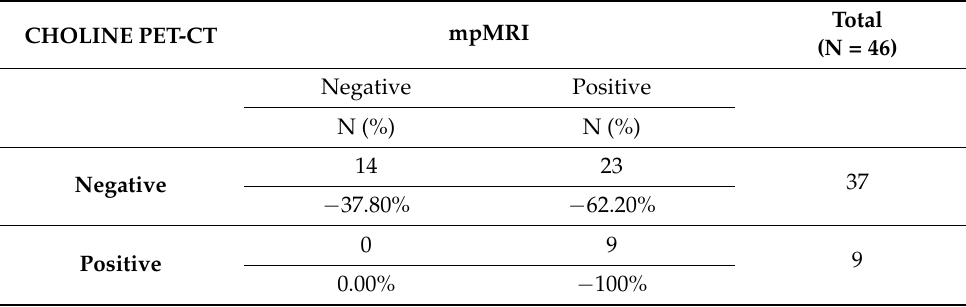
Table 4. Comparison between mpMRI and Choline